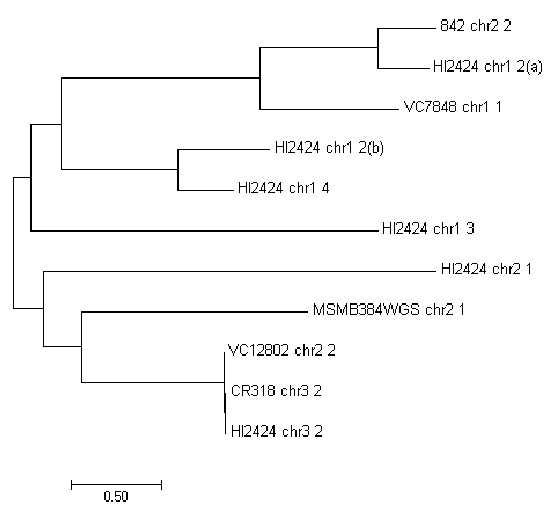
Figure 3. Maximum likelihood comparison of the MFS proteins found in examined strains.